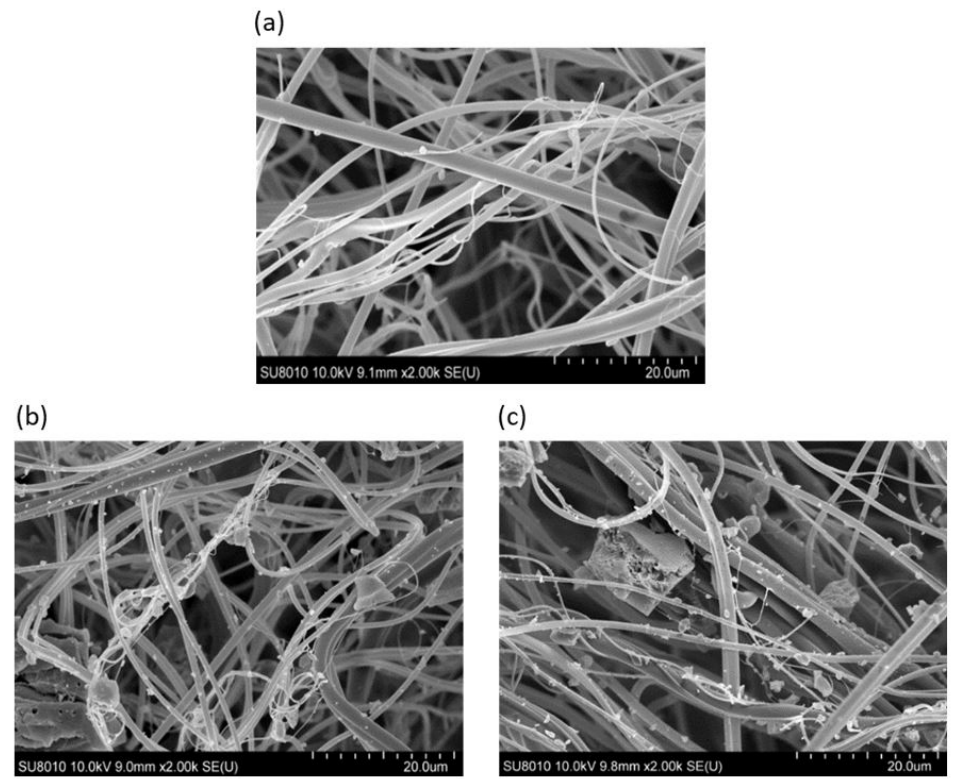
Figure 3. SEM images of the polypropylene filtration non-woven fabric without sorbent: ( a ) PP non-woven fabric containing; ( b ) 30 g of AG Pleisch carbon sorbent after 240 min of pulverizing and PP non-woven fabric containing; ( c ) 30 g of SAR carbon sorbent after 240 min of pulverizing.